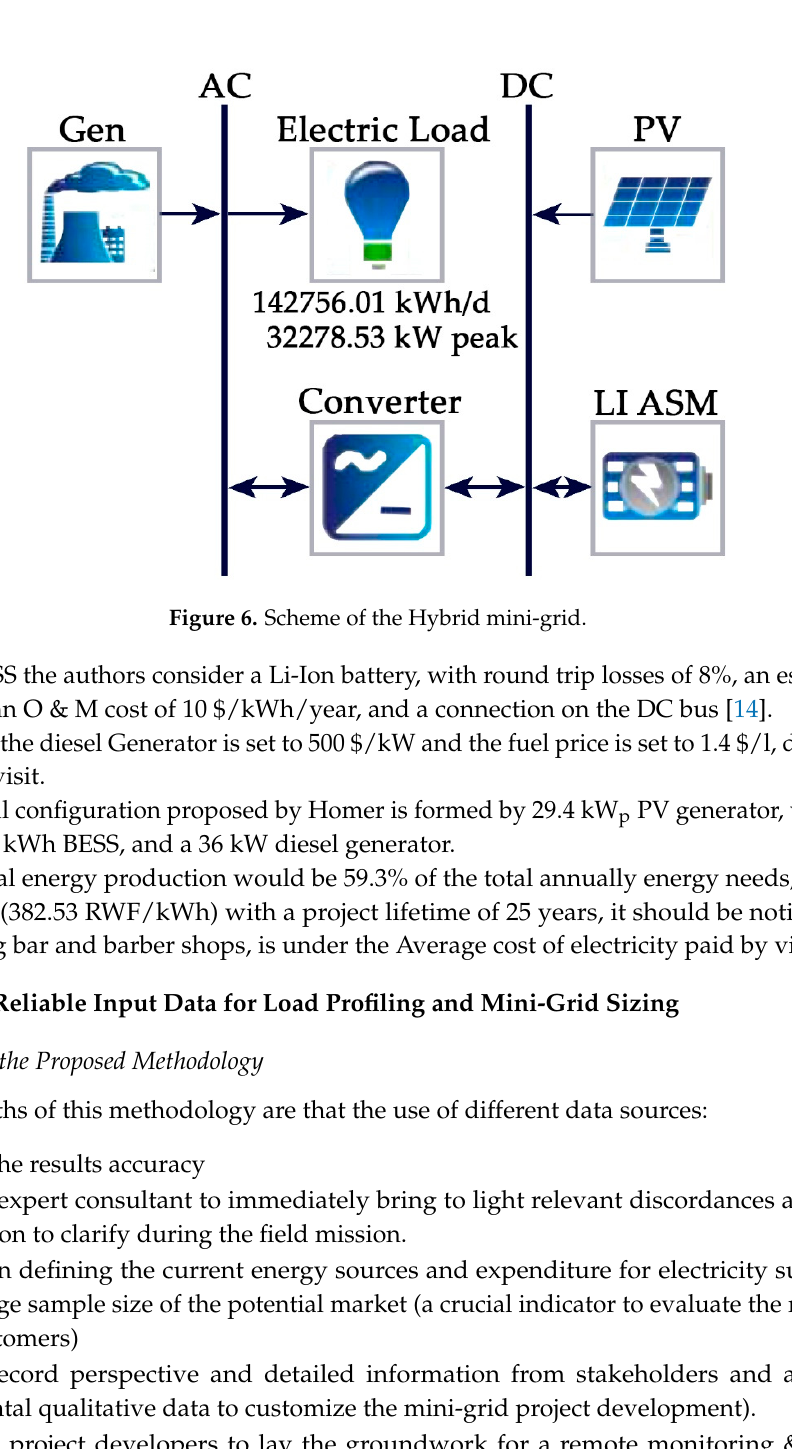
Figure 5. Assumed average daily solar irradiation and clearness index for the plant location.